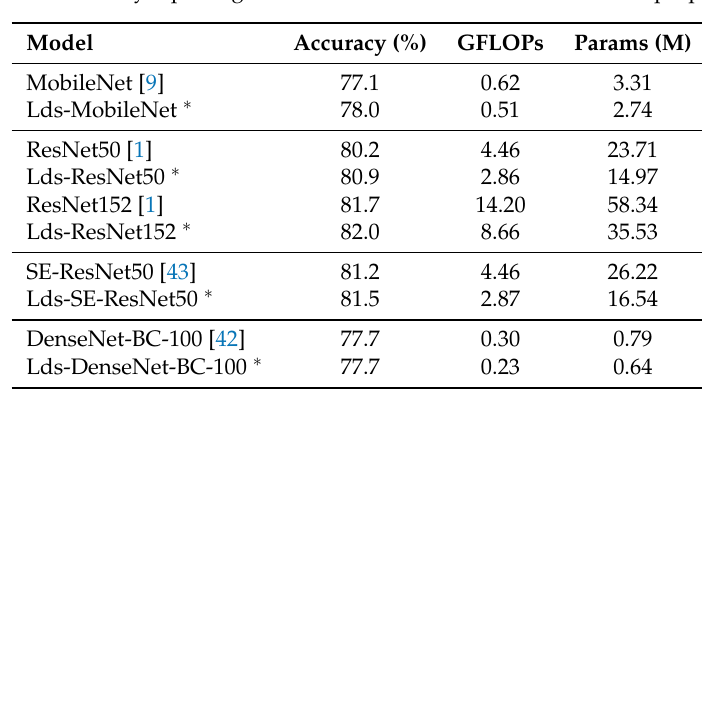
Table 2. The table shows the results for different models on CIFAR-100. ‘ ∗ ’ refers to the LdsConv using the balance loss. With the setting obtained from the ablation study, we can simply improve the performance of the model by replacing the standard 3 × 3 convolution with our proposed